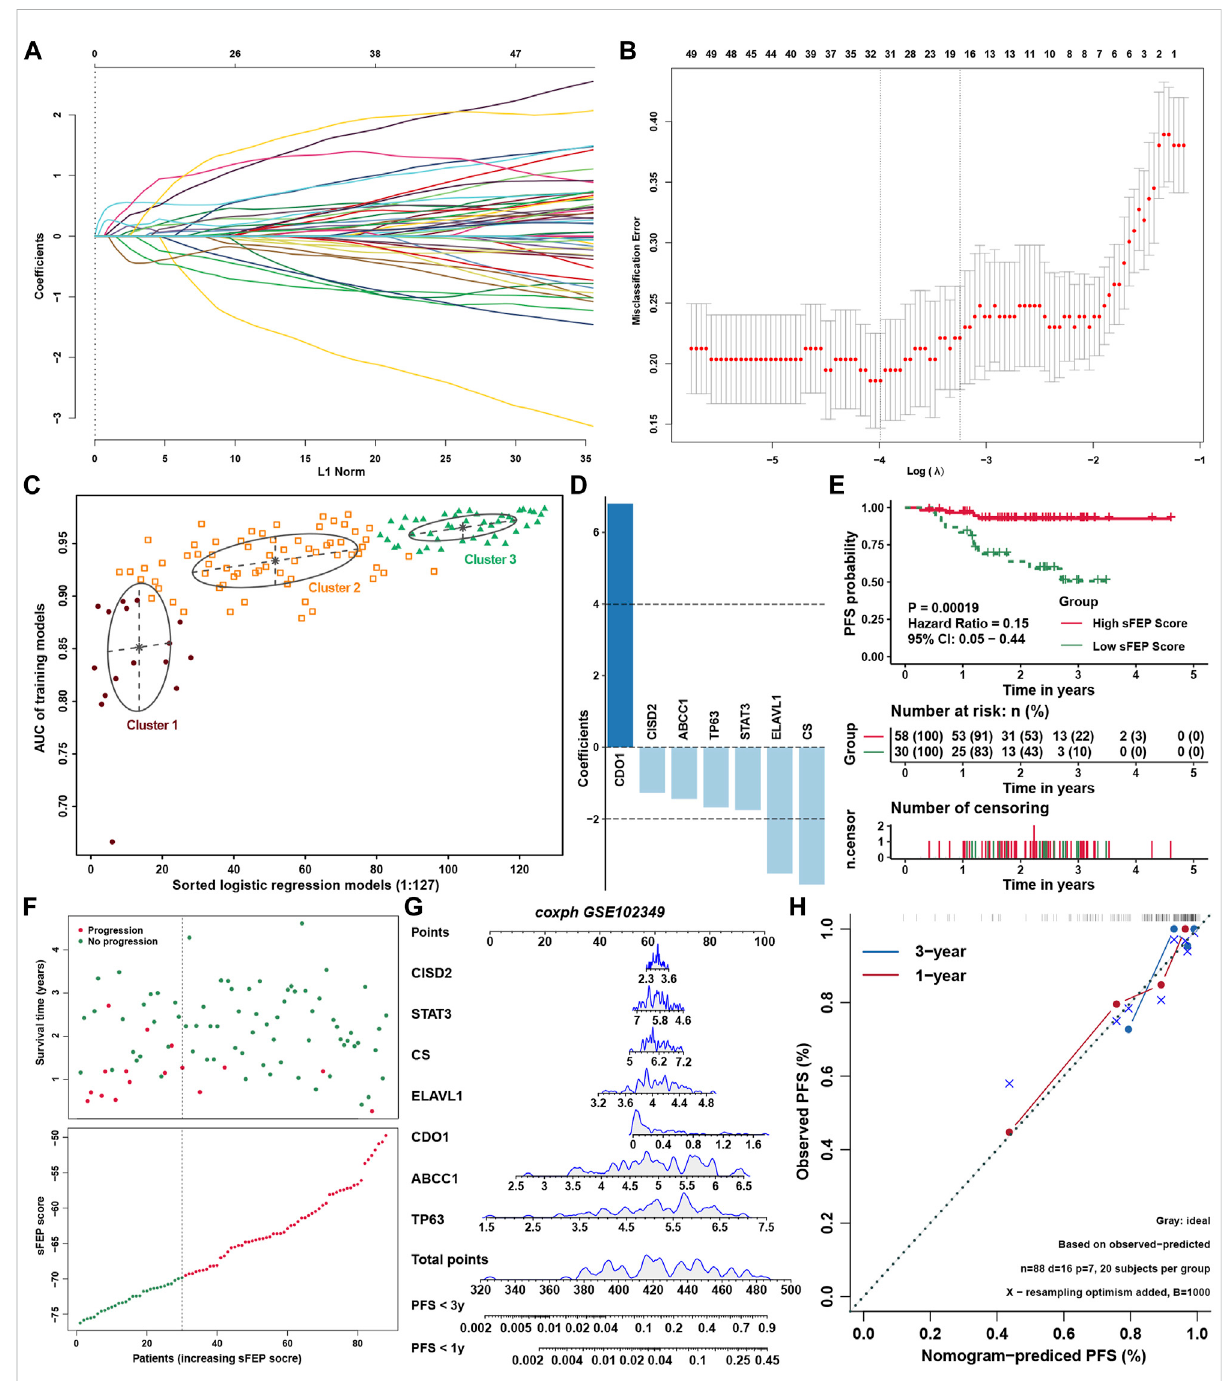
FIGURE 8 Construction of prediction model. (A) LASSO coef fi cient pro fi les of ferroptosis regulators. (B) Ten-time cross-validation for tuning parameter selection intheLASSO model for ferroptosis regulators. (C) The pattern ofthelogistic regressionmodelcorrelatedwith theAUC scores identi fi edby aGaussianmixture.Thereare3clustersof127combinations. (D) Thecoef fi cientsofsevengenesinvolvedinsFEPscoresignature. (E) Survivalanalysis forsFEPscoreinGSE102349. (F) ThesFEPscoredistributioninthepatientswithNPCandtheprogressionstatusofNPCfromdifferentgroupsof sFEP scores. (G) The nomogram to predict one-year and three-year PFS outcomes of NPC patients. (H) The calibration curve to evaluate the accuracy of the nomogram constructed based on sFEP